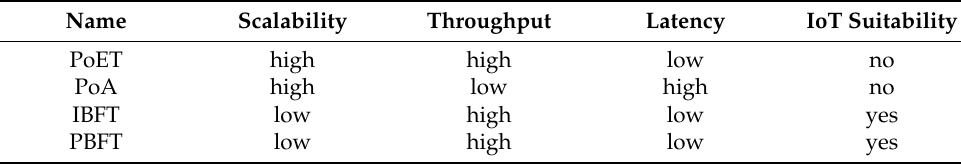
Table 1. Comparison of consensus